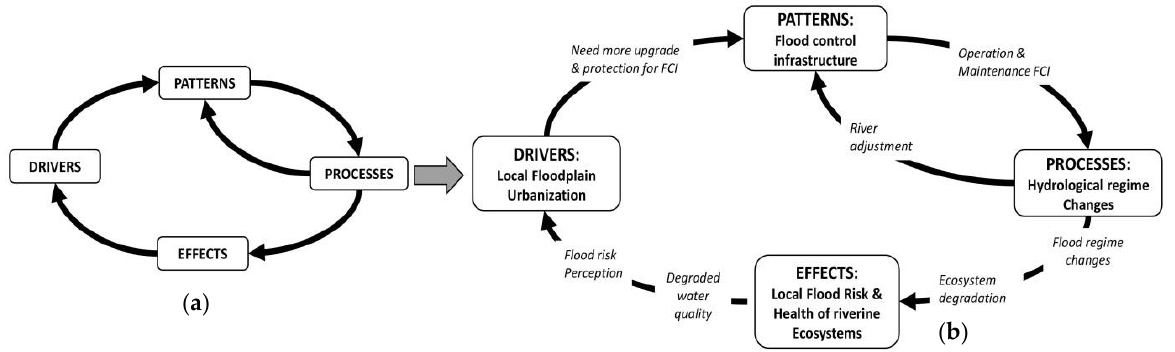
Figure 2. ( a ) Alberti’s model of urban ecology [22] is applied to provide insight into the complex dynamics induced by flood control infrastructure (FCI) in the VMD. This model emphasizes the linkage between components and processes, and describes the feedback loop. The structural simplicity of the model allows for easy integration between hierarchies. The analytical framework ( b ) is developed to emphasize the models and processes that link the two components of humans and the ecosystem, describes the feedback mechanism in which human actions affect and are affected by components of the ecosystem, and the degree of interaction at different scales [5,23]. There are many factors involved in human–river interactions associated with FCI, but this study focuses on riverine urbanization, hydrological regime change, flood control, flood risk, and the riverine